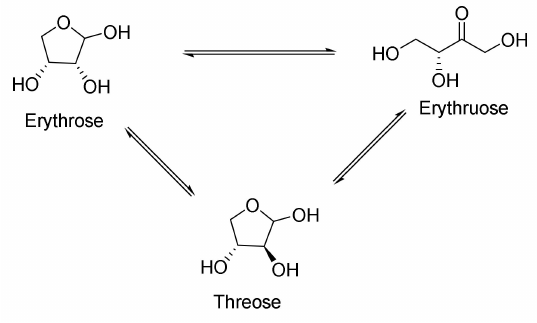
Figure 10. Schematic illustration of the conversion of tetroses by